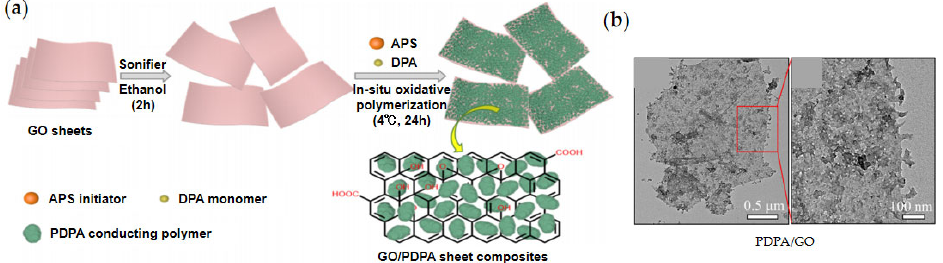
Figure 5. Schematic preparation of GO/PDPA by in situ oxide polymerization of DPA on the surface of GO ( a ) and corresponding TEM images of GO/PDPA ( b ) with different resolutions [82].